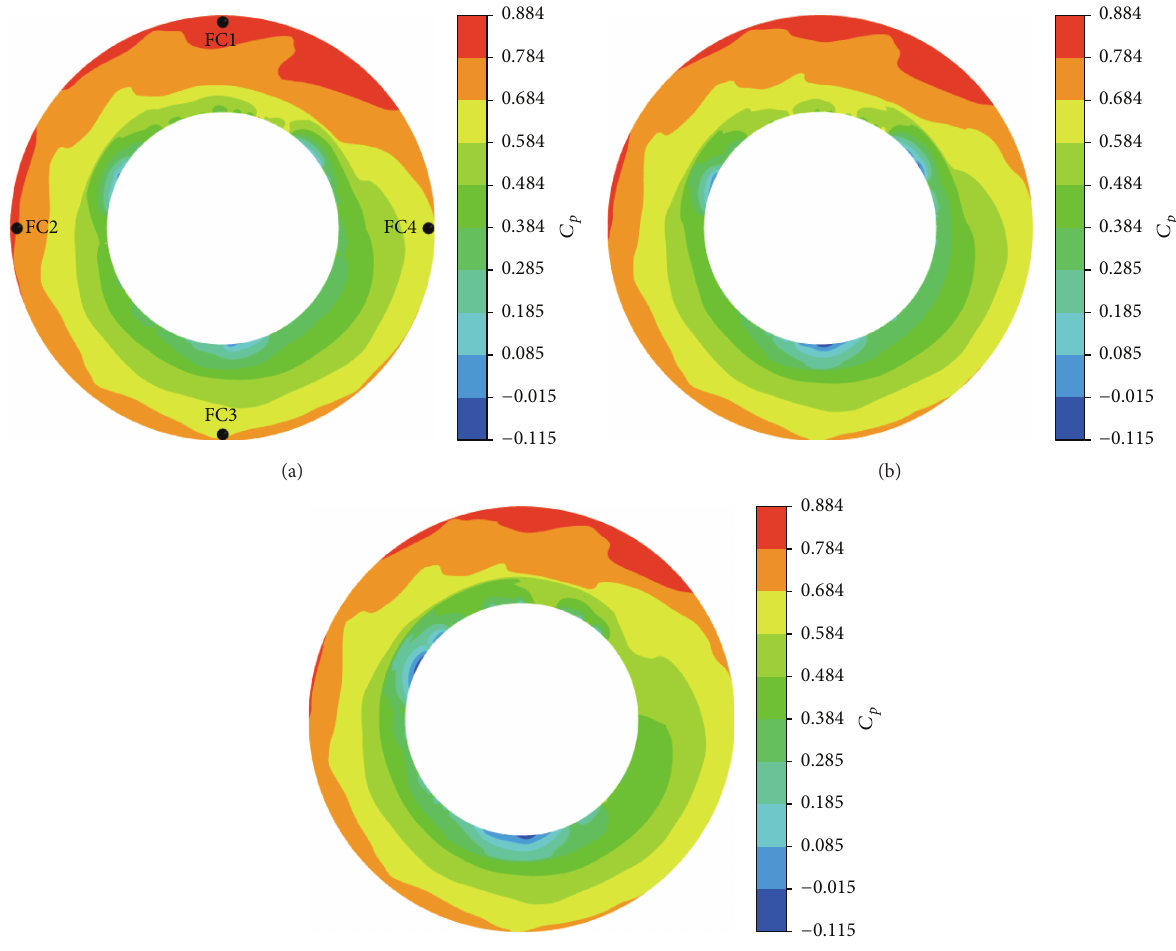
Figure 11: Pressure coefficient distribution on one section of the front gap at the last timestep: (a) M1, (b) M2, and (c) M3.